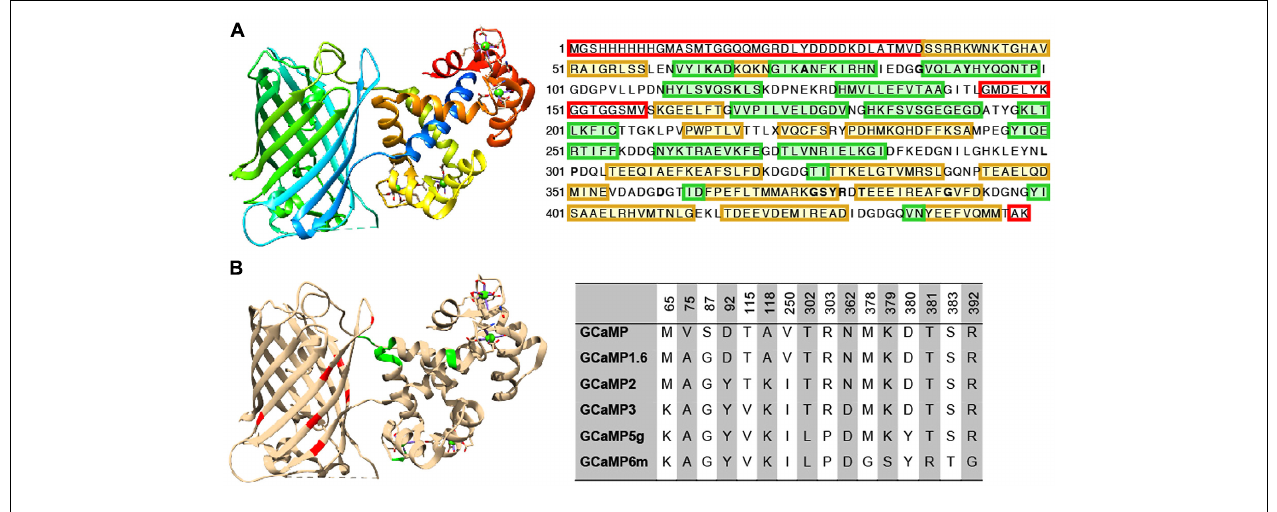
FIGURE 2 | Structure and beneficial mutations of GCaMPs. (A) Crystal structure (Ding etal., 2014) and primary sequence of GCaMP6m. Distinct regions of the crystal structure are indicated by color. The cooler the color, the closer the sequence is to N-terminus. The primary sequence is annotated such that yellow shading corresponds to ß-strands, green shading corresponds to α -helices, and residues in red are those that do not crystallize (i.e., pRSET domain and linkers). (B) Beneficial mutations of